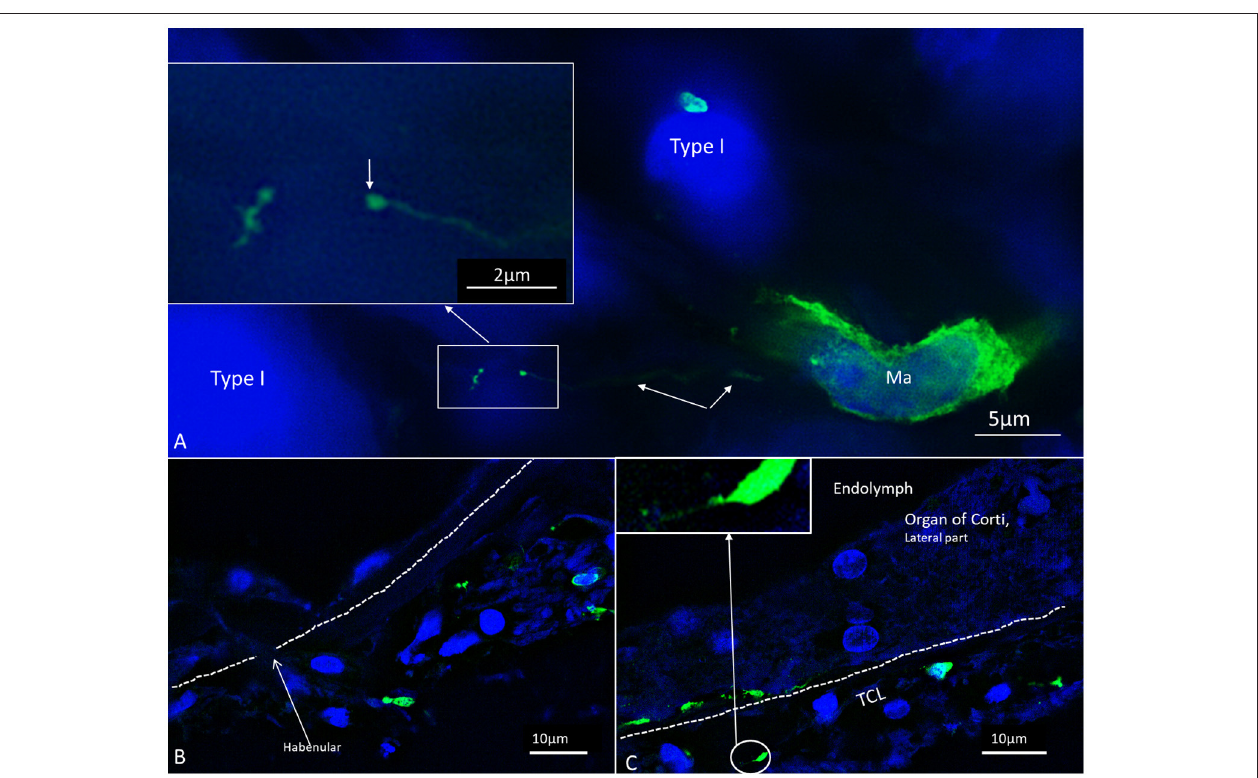
FIGURE 5 | SR-SIM of macrophages in the spiral ganglion (A) and OC (B,C) . The cells exhibit thin (0.1–0.2 µ m) filamentous processes extending into the extracellular tissue to adhere to surrounding cells ending with a small knob (arrow). The dimension suggests that cell processes may reach the OC for surveillance through the HP.